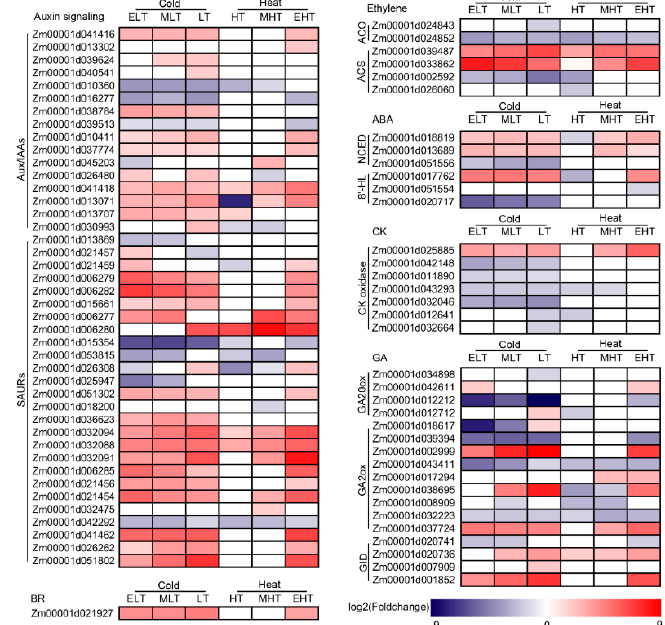
Figure 5. Heatmap of the differentially expressed genes involved in hormone signaling in response to temperature stress. ACS, 1-aminocyclopropane-1-carboxylate (ACC) synthesis (ACS); ACO, ACC oxidase; NCED, 9-cis-epoxycarotenoid dioxygenase; GA2ox, GA2 oxidase; GA20ox, GA20 oxidase; GID, gibberellin insensitive dwarf; and BR, brassinosteroids. ELT, extreme low temperature, 4 °C; MLT, medium low temperature, 10 °C; LT, low temperature, 16 °C; NT, normal temperature, 25 °C; HT, high temperature, 37 °C; MHT, medium high temperature, 42 °C; and EHT, extreme high temperature, 48 °C.